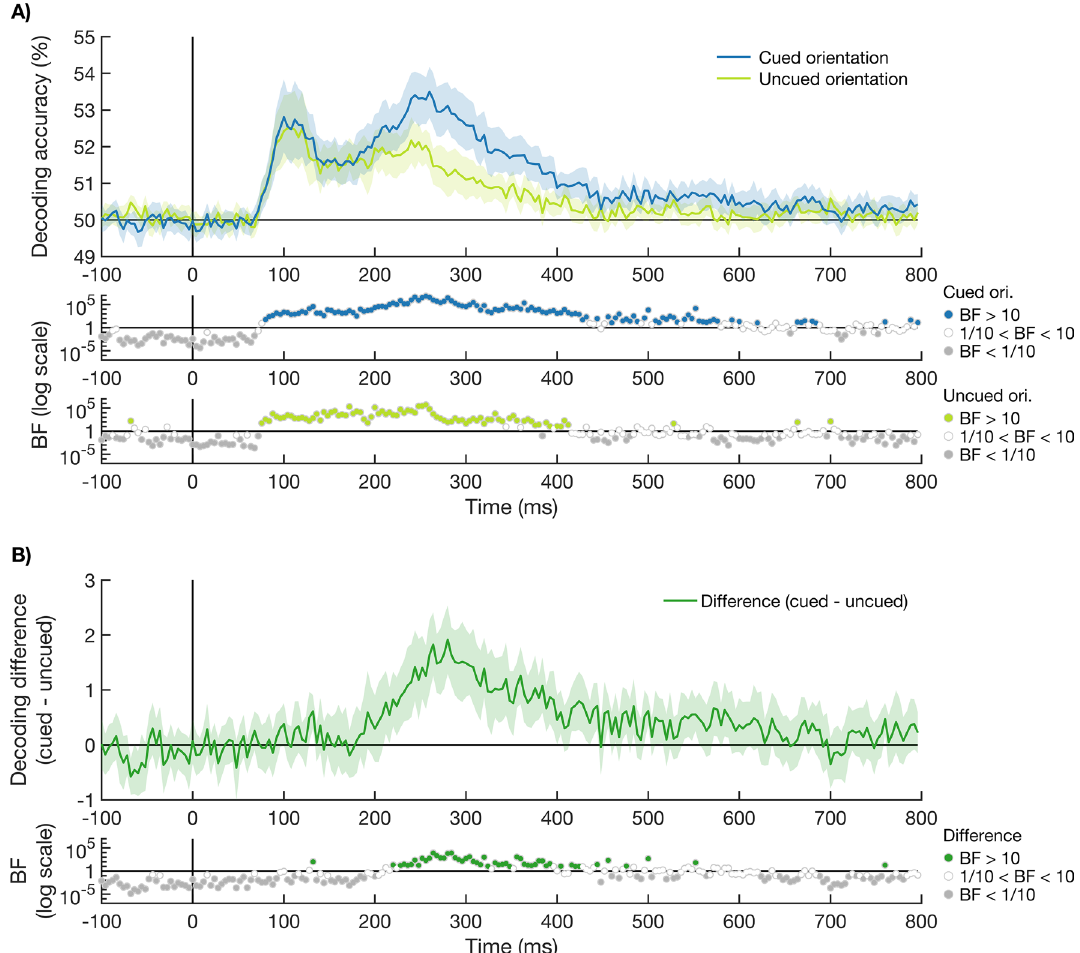
Figure 2. Time-course of decoding accuracies of the cued and uncued orientations. ( A ) shows the decoding accuracy of the stimulus orientation over time, when the orientation was either presented in the cued colour (blue) or uncued (light green). The stimulus onset is marked with a vertical black line at 0 ms. Theoretical chance is 50% decoding accuracy, and shaded areas around the plot lines show the bootstrapped 95% confidence interval across participants (N = 20). Bayes factors are given below the plot on a log scale. Bayes factors below 1/10 are shown in grey, indicating strong evidence for the null hypothesis. Bayes factors above 10 are shown in the plot colour (blue for cued and light green for uncued), indicating strong evidence for the alternative hypothesis. Bayes factors between 1/10 and 10 are shown in white. The cued orientation could be decoded from 84 ms after the onset of the stimulus, and the uncued orientation from 80 ms after stimulus onset. ( B ) shows the effect of attention, measured as the difference in orientation decoding between the cued and uncued orientation (cued − uncued). The Bayes factors are given below the plot on a log scale. An effect of attention was present from 232 ms after stimulus